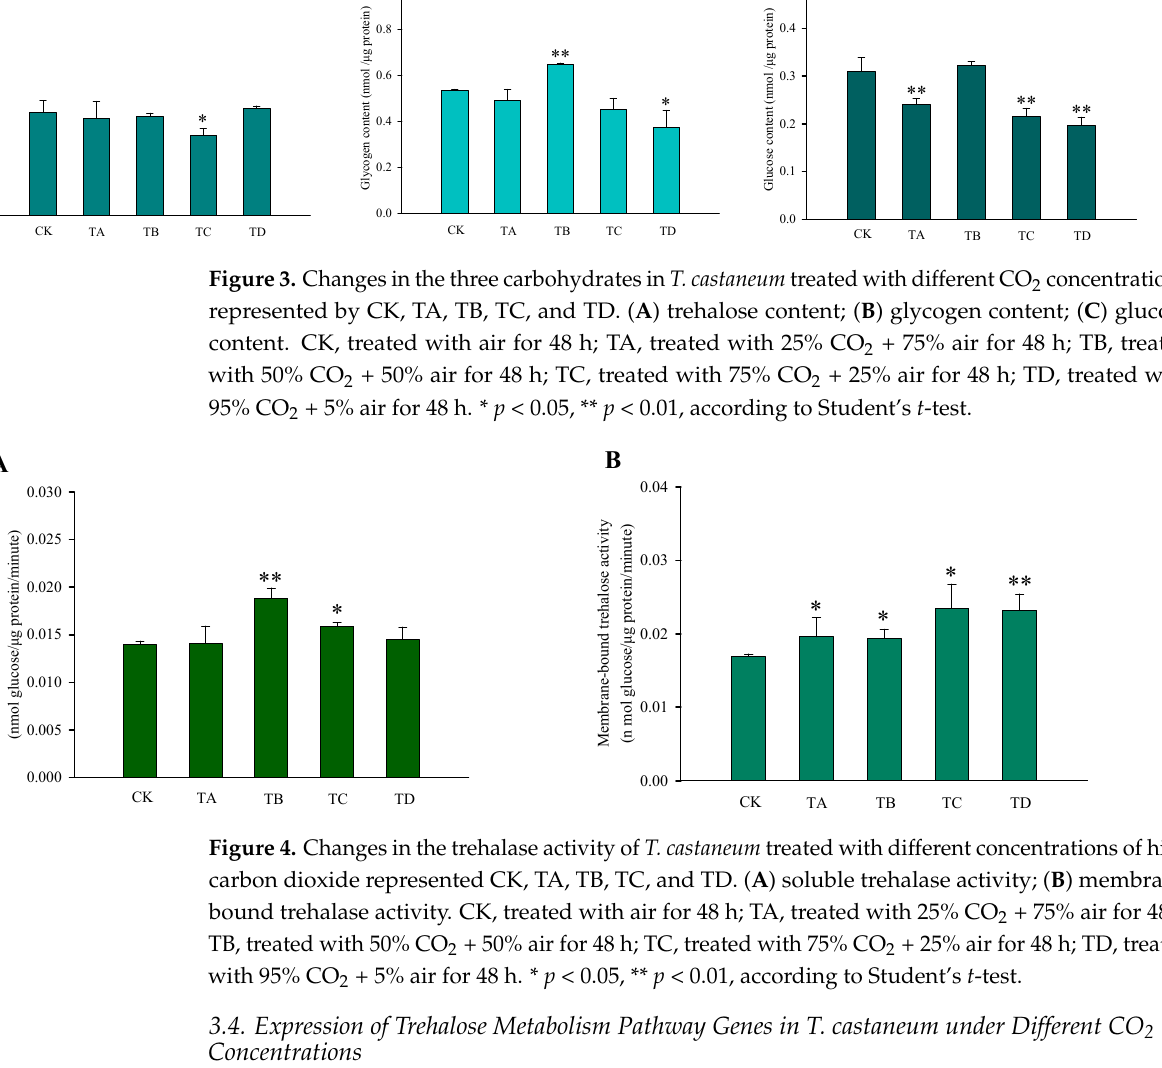
Compared with the control group, TPS , TRE1 ‐ 2, and TRE1 ‐ 3 displayed significantly higher levels of expression after 48 h of CO 2 treatment (Figure 5A,C,D). In contrast, the